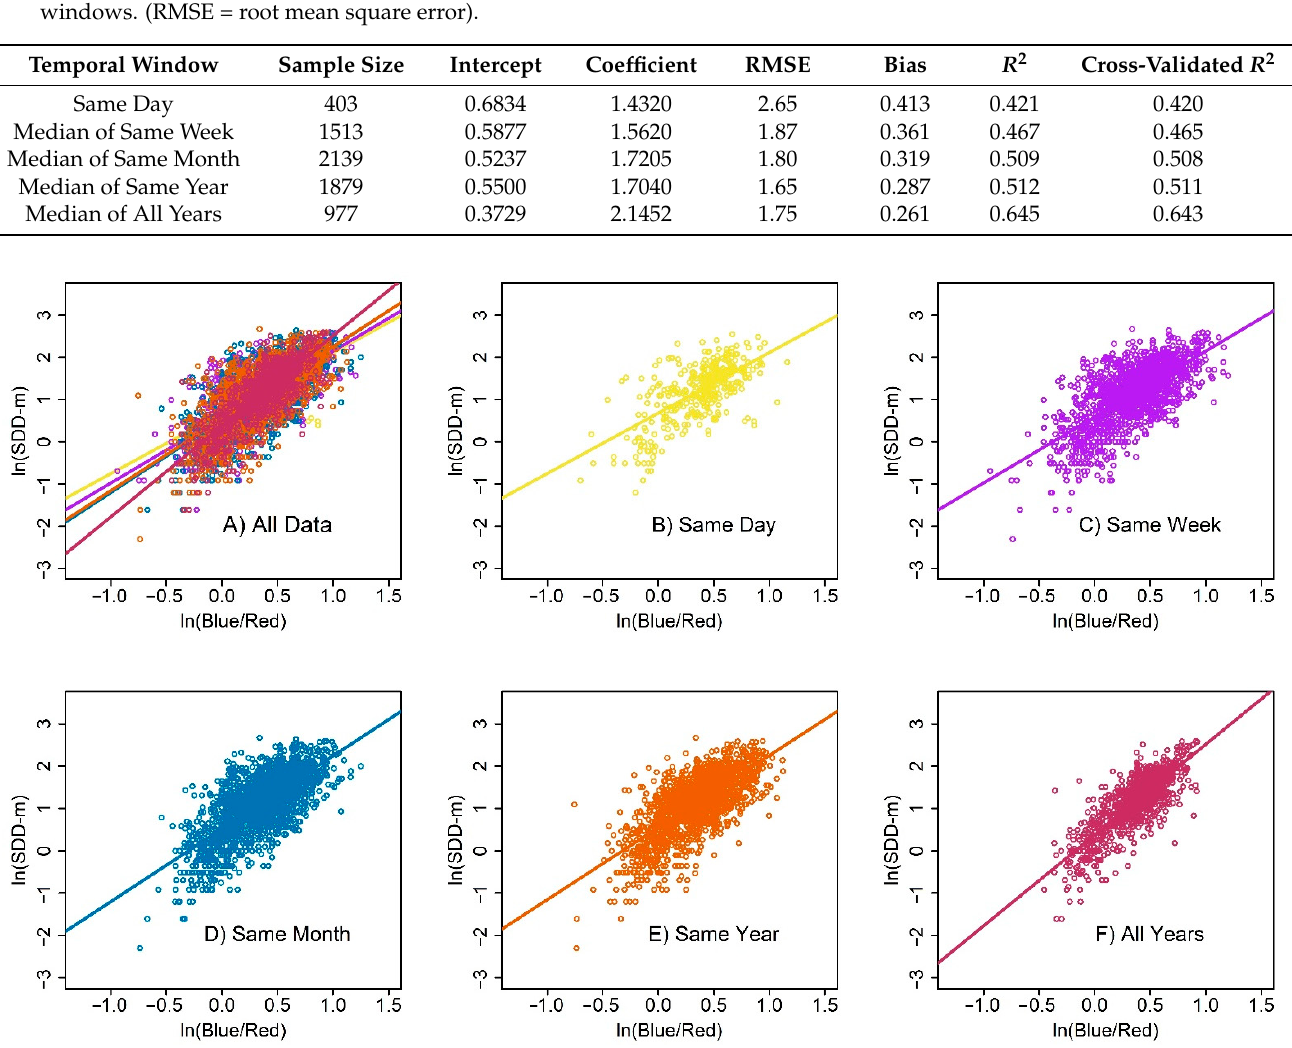
Figure 7. Scatterplots of ln(SDD) versus ln(Blue/Red) for ( A ) all time windows together, ( B ) SDD versus median Blue/Red within a 1-day window, ( C ) median SDD versus median Blue/Red within a 7-day window, ( D ) median SDD versus median Blue/Red within a 30-day window, ( E ) median SDD versus median Blue/Red within a single season, and ( F ) median SDD versus median Blue/Red over the entire Landsat 8 record (2013–2019) per sample station. Note, in graph A, lines for ‘Same Day’ (yellow) and ‘Same Week’ (purple), and lines for ‘Same Month’ (blue) and ‘Same Year’ (Orange) overlap.